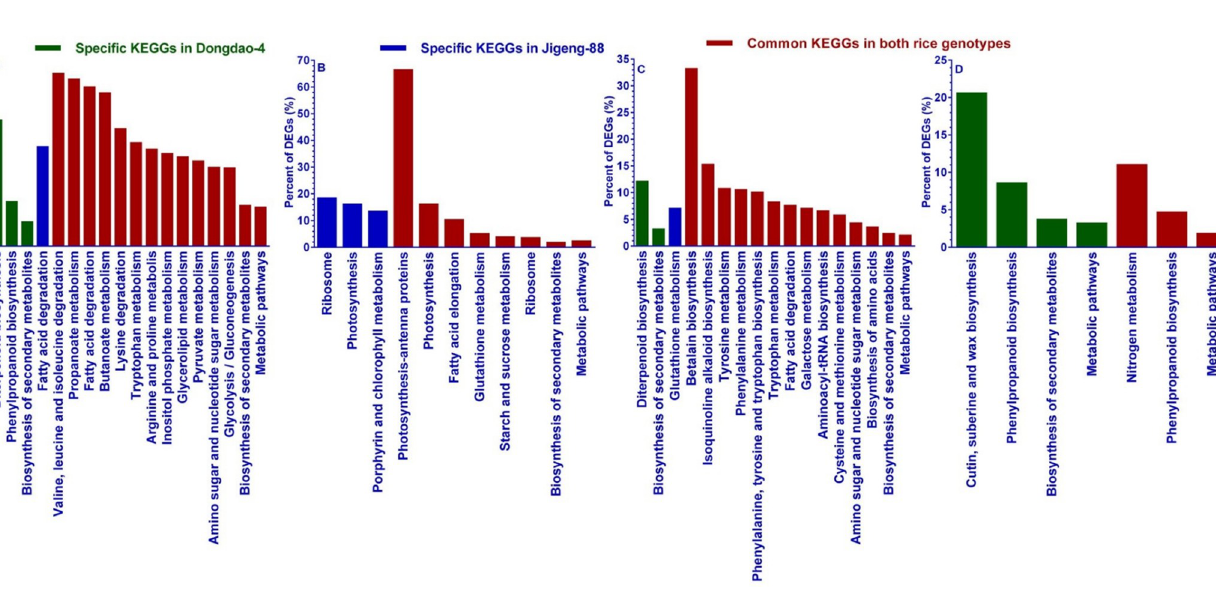
Fig 5. KEGG terms significantly enriched by differentially regulated genes in Dongdao-4 and Jigeng-88. (A) KEGG terms specifically enriched by upregulated DEGs in shoots, (B) KEGG terms specifically enriched by downregulated DEGs in shoots, (C) KEGG terms specifically enriched by upregulated DEGs in roots, (D) KEGG terms specifically enriched by downregulated DEGs in